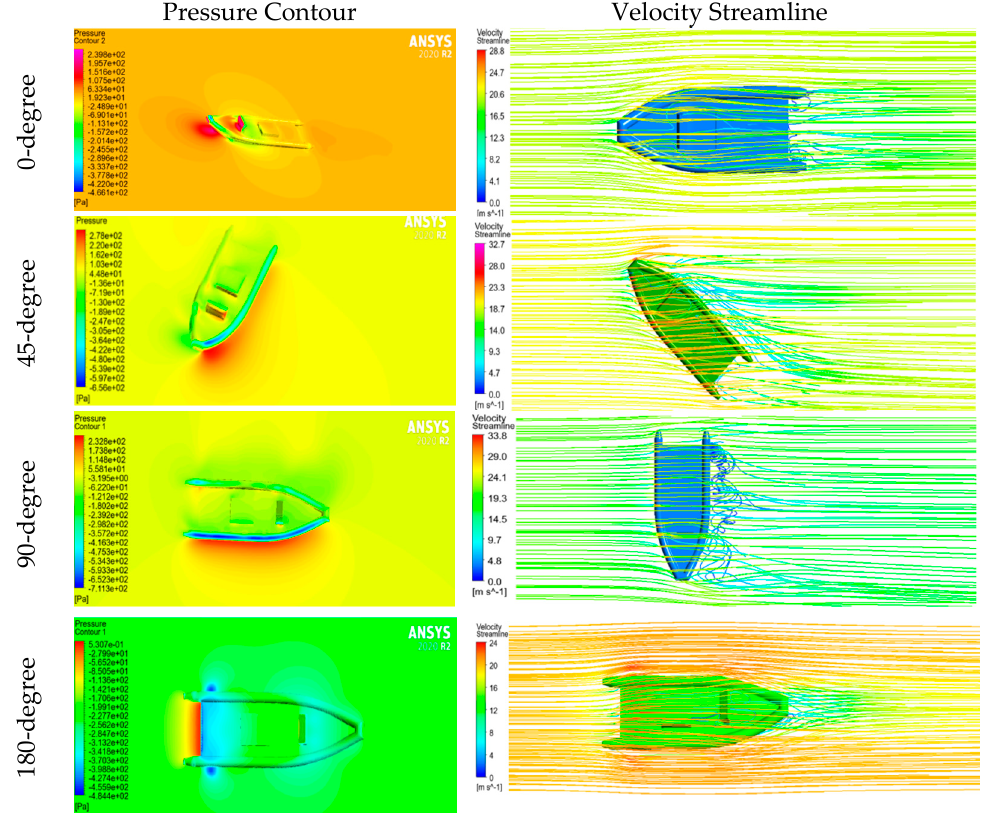
Figure 10. The wind characteristics of 0, 45, 90, and 180 degrees at wind speeds of 20